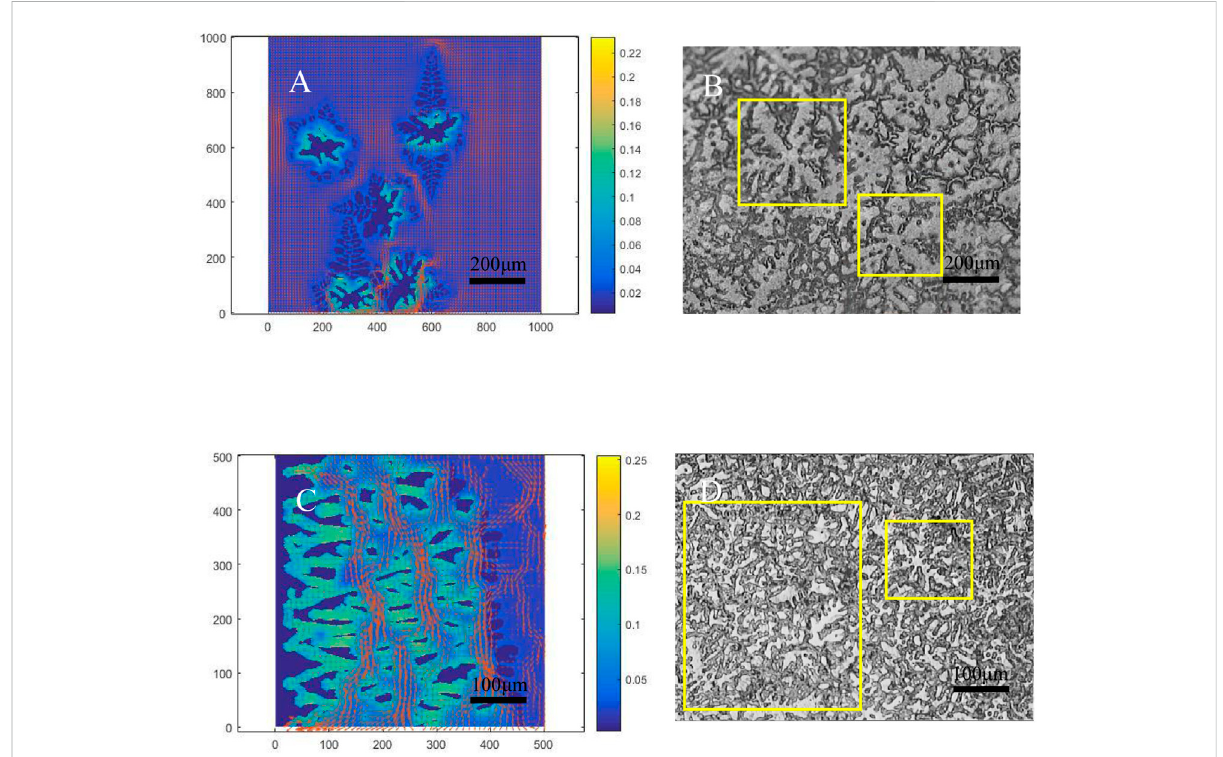
FIGURE 7 Phase fi eldsimulationresultsandmicrostructurecomparisonofMagnesiumAlloy: (A) Simulationresultsofsoluteremeltingofequiaxedcrystals in the central area of roll casting; (B) Microstructure of central area of roll casting after experiment; (C) Simulation results of dendrites melt